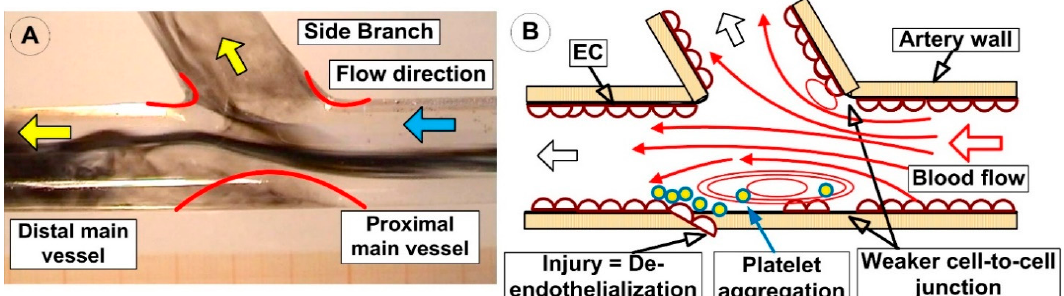
Figure 2. Flow hemodynamics of the artery bifurcation. ( A ) Development of the low wall shear stress (WSS) regions on the bottom wall of the main vessel in the opposite of the side branch, as well as along the lateral wall of the branch itself; ( B ) Flow bifurcation induces local vortices both in the distal main vessel and side branch and also creates a stagnation region with a long residence time for circulating particles. Flow deceleration and recirculation promote longer residence times, increased collision rates, and increased platelet aggregation. Low shear rates observed in these regions also favor the adhesion of platelets at the vascular wall. Platelets potentially activated by exposure to high shear and subsequently entrapped in vortices could potentially lead to the formation of free